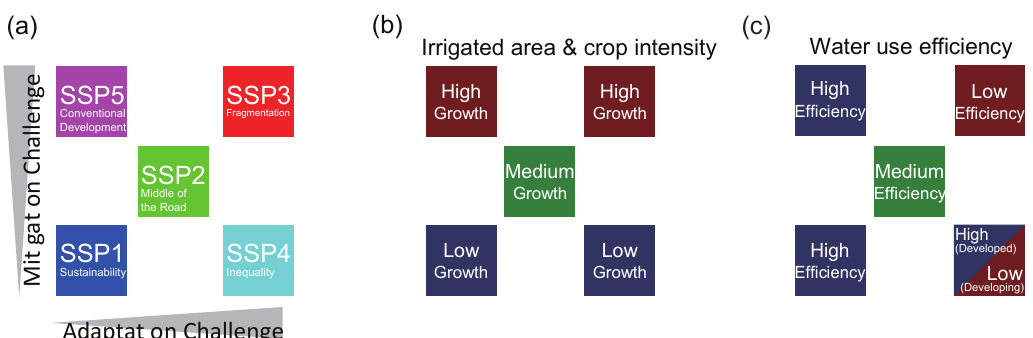
Fig. 1. (a) The five SSPs in a conceptual space of adaptation and mitigation challenges (after O’Neill et al., 2012). (b) Scenarios for irrigated area and crop intensity. (c) Scenarios for water use